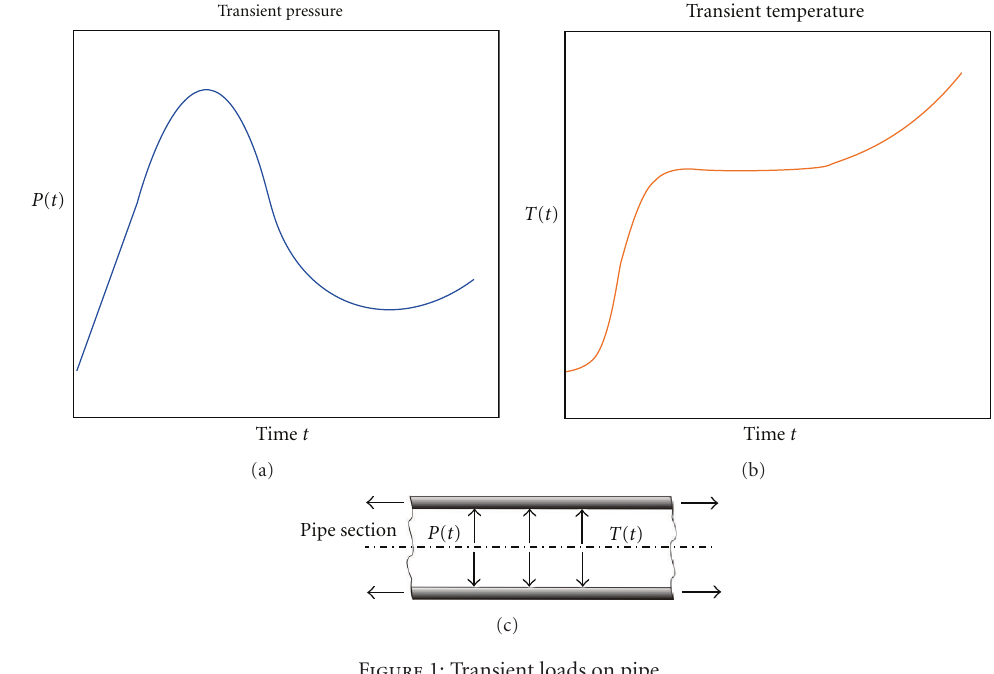
Figure 1: Transient loads on pipe.